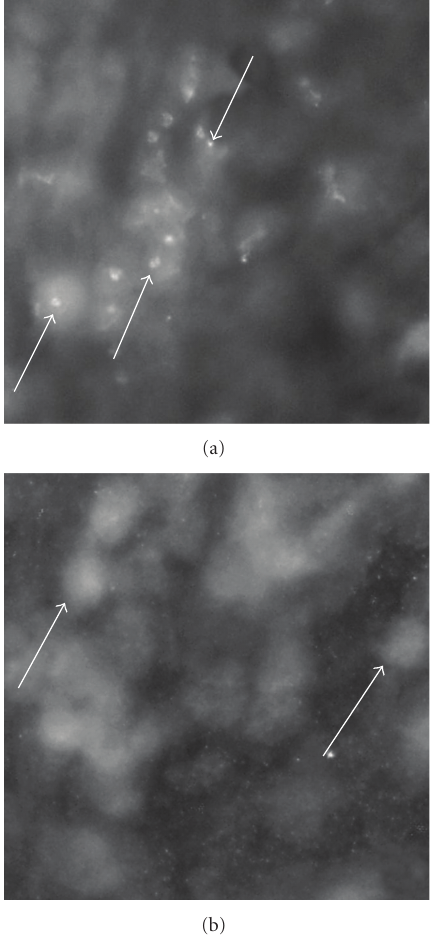
Figure 2: (a, b) Sections of synovial tissue of a patient with rheuma- toid arthritis. The sections were stained for demonstration of TNF- alpha (a) and for TNF-alpha after preabsorption with TNF-alpha antigen (b). Inflammatory cells show specific immunoreaction in (a) (arrows). There are no specific immunoreactions in these in (b) (arrows). The inflammatory cells had in parallel sections been identified via staining for routine morphology (htx eosin).